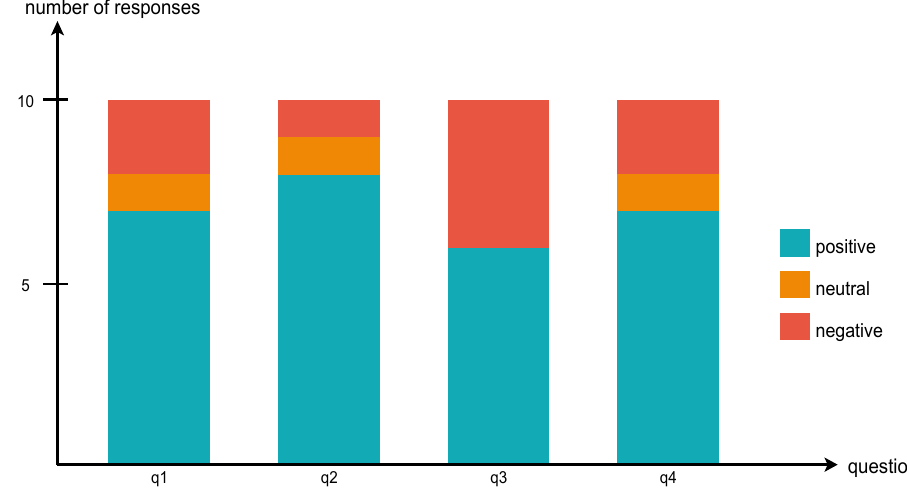
Figure 8. Participants’ responses to experiments using